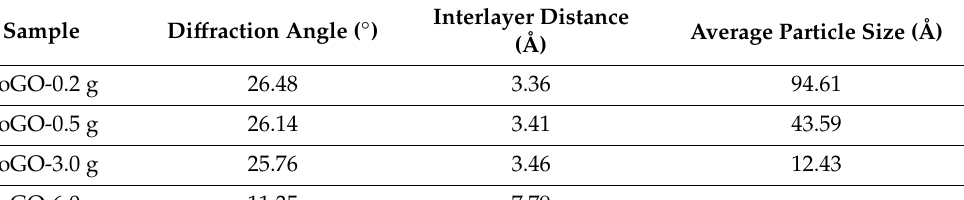
Table 3. XRD measurements of (002) reflection of poGOs, interlayer distances, and average size of particles in poGOs, calculated by the Bragg equation and Debye–Scherrer method.